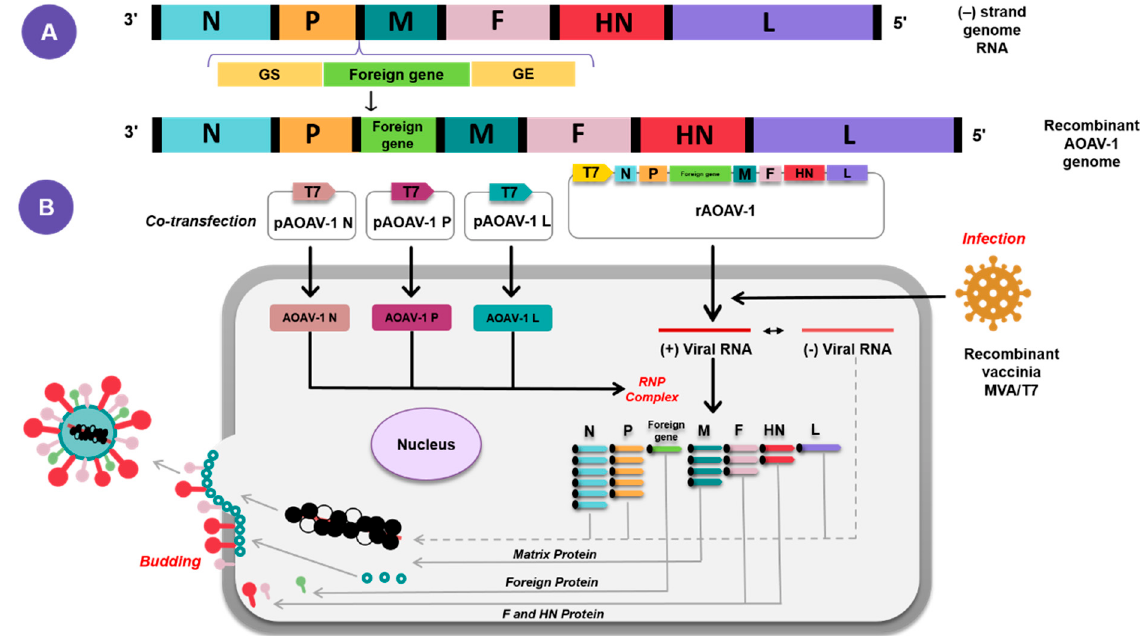
Figure 3. Diagrammatic representation of the reverse genetics strategy for AOAV ‐ 1 rescue. Construction of recombinant AOAV ‐ 1 containing foreign gene ( A ). The recombinant AOAV ‐ 1 will be co ‐ transfected together with expression helper plasmids encoding the N, P, and L proteins of AOAV ‐ 1 and infected with recombinant vaccinia MVA/T7 expressing T7 RNA polymerase (B) .